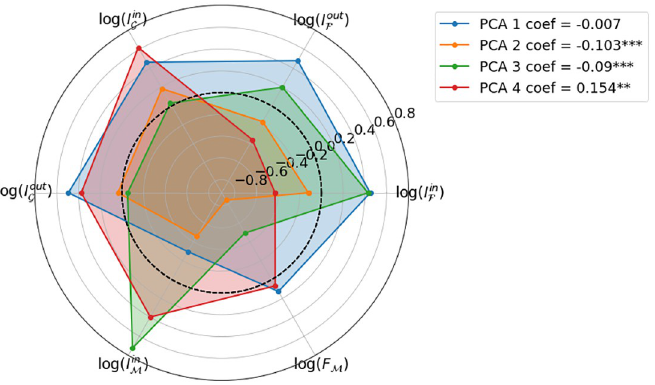
Fig 3. Composition of the first 4 PCA components accounting for 98% of the variance in the data. We show the estimated effects of this variables on GDP, which are mostly statistically significant.